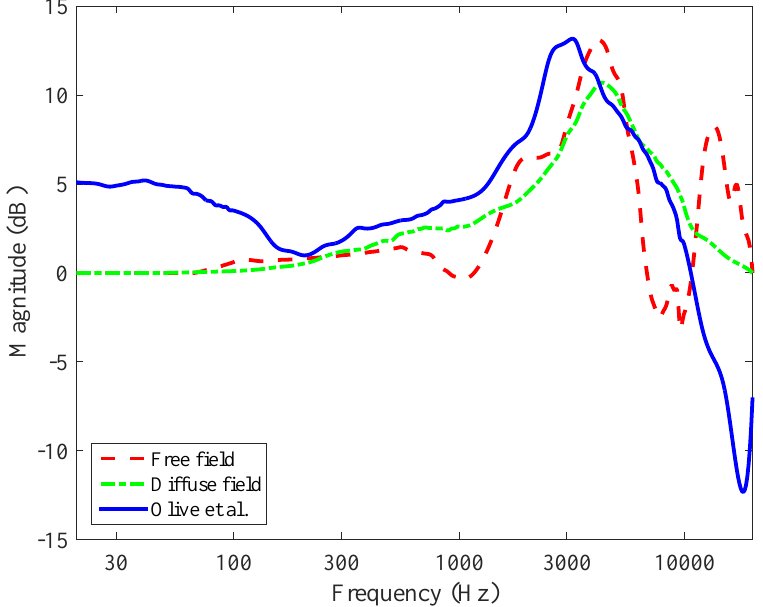
Figure 16. Various target responses for headphones: free field, diffuse field, and preferred response simulating in-room loudspeaker response proposed by Olive et al .